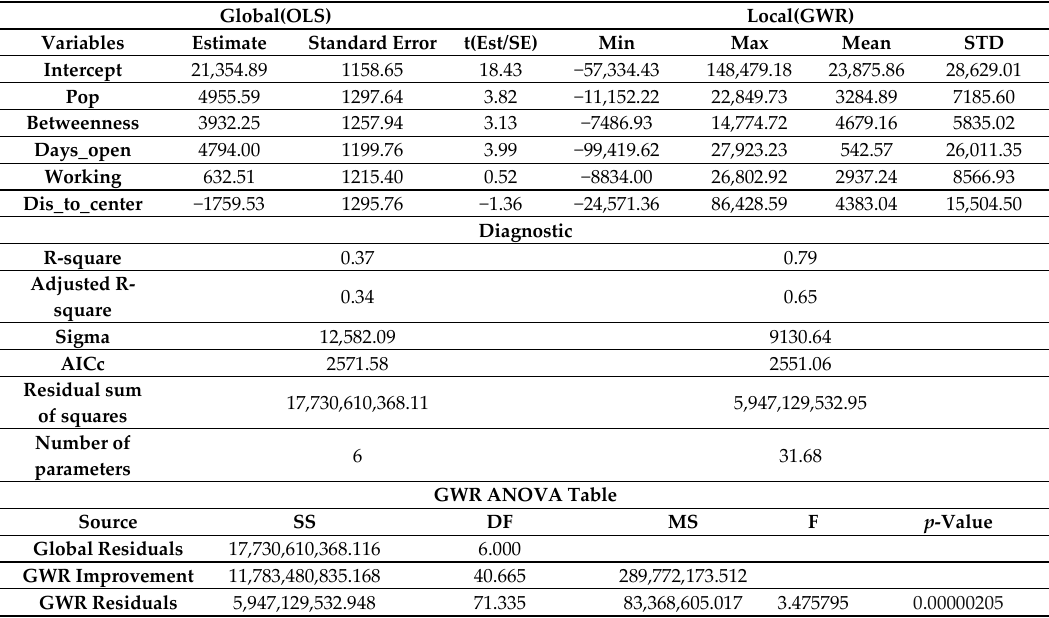
Table A2. Results of the model for Weekday_ridership.